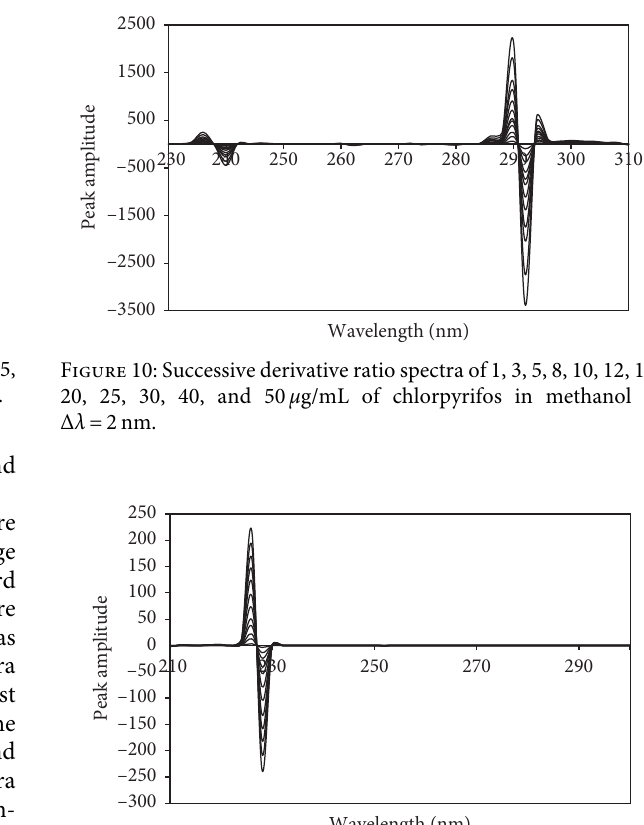
25, 30, 35, 40, and 45 μ g/mL of tebuconazole in methanol at